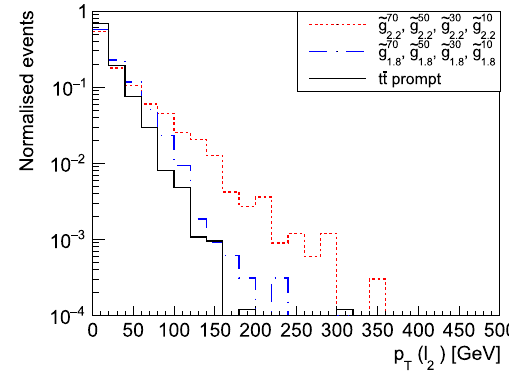
Fig. 78 Transverse momentum p T of the second leading lepton in the gluino ˜ g case